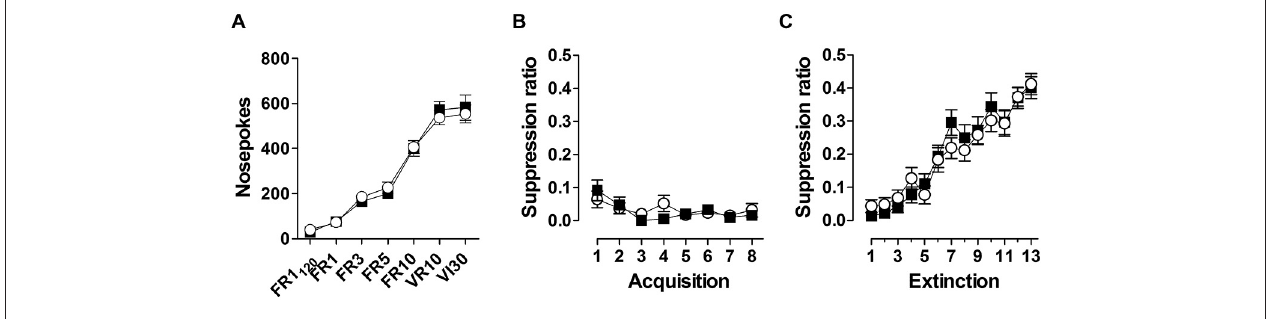
suppressed instrumental responding robustly (B) , which recovered during subsequent extinction trials (C) . Data are expressed as means ± SEM. No difference in performance between WT (black symbols) and Nxf7 KO (white symbols) were observed.